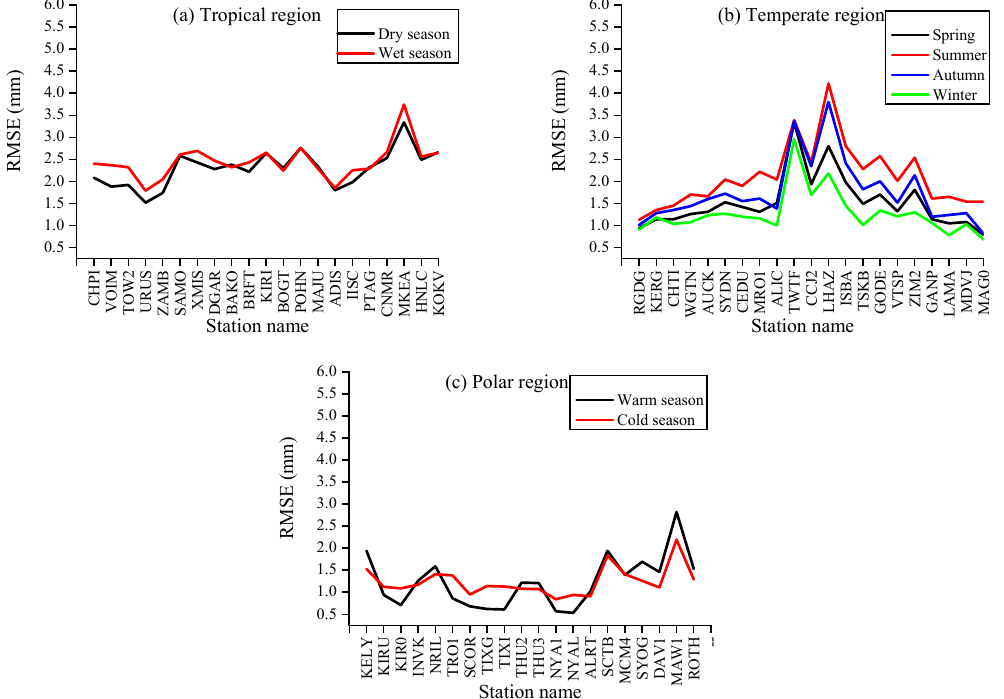
Figure 7. Seasonal variations of the accuracy of ERA5 reanalysis water vapor product in the different climatic zones (source: own elaboration).